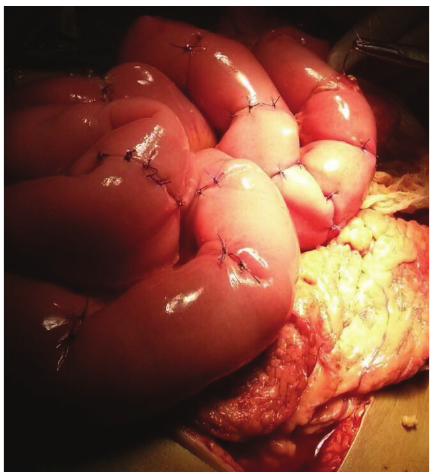
Figure 2: Multiple small bowel perforations.